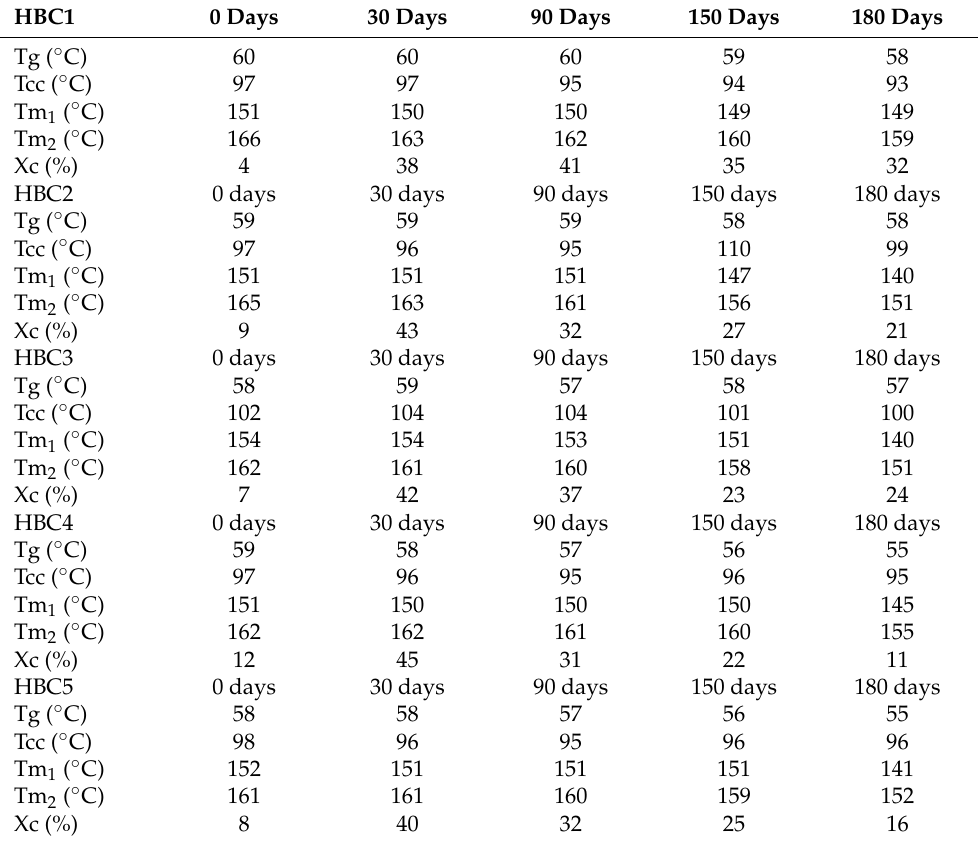
Table 2. Tg, Tcc, Tm 1 and Tm 2 and Xc of HBCs with 0, 30, 60, 90, 120 and 150 days of